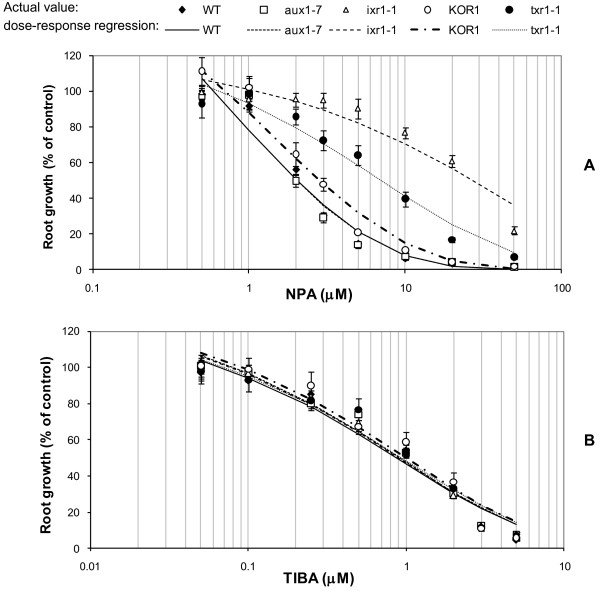
Impact of auxin transport inhibitors on root growth of Arabidopsis lines. Wild type and mutant Arabidopsis thaliana seedlings were treated for 72 h on medium containing: (A) 1-napthylphthalamic acid – NPA, or (B) 2,3,5-Triiodobenzoic acid - TIBA. Individual data points are expressed as mean percentages ± SE (n = 20) of control root growth on medium with no exogenous auxin transport inhibitors applied.